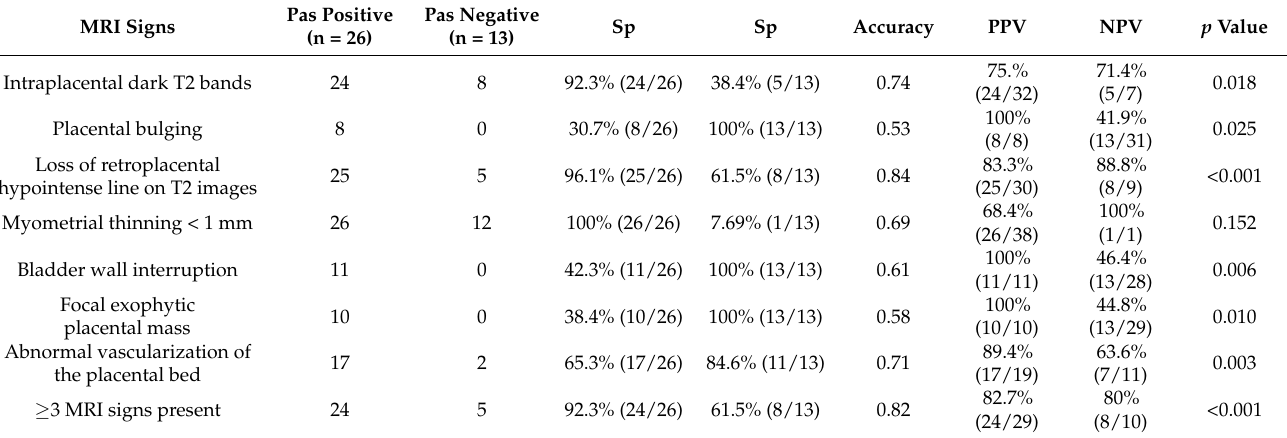
Table legend: Se—sensibility; Sp—specificity; PPV—positive predictive value; NPV—negative predictive value.